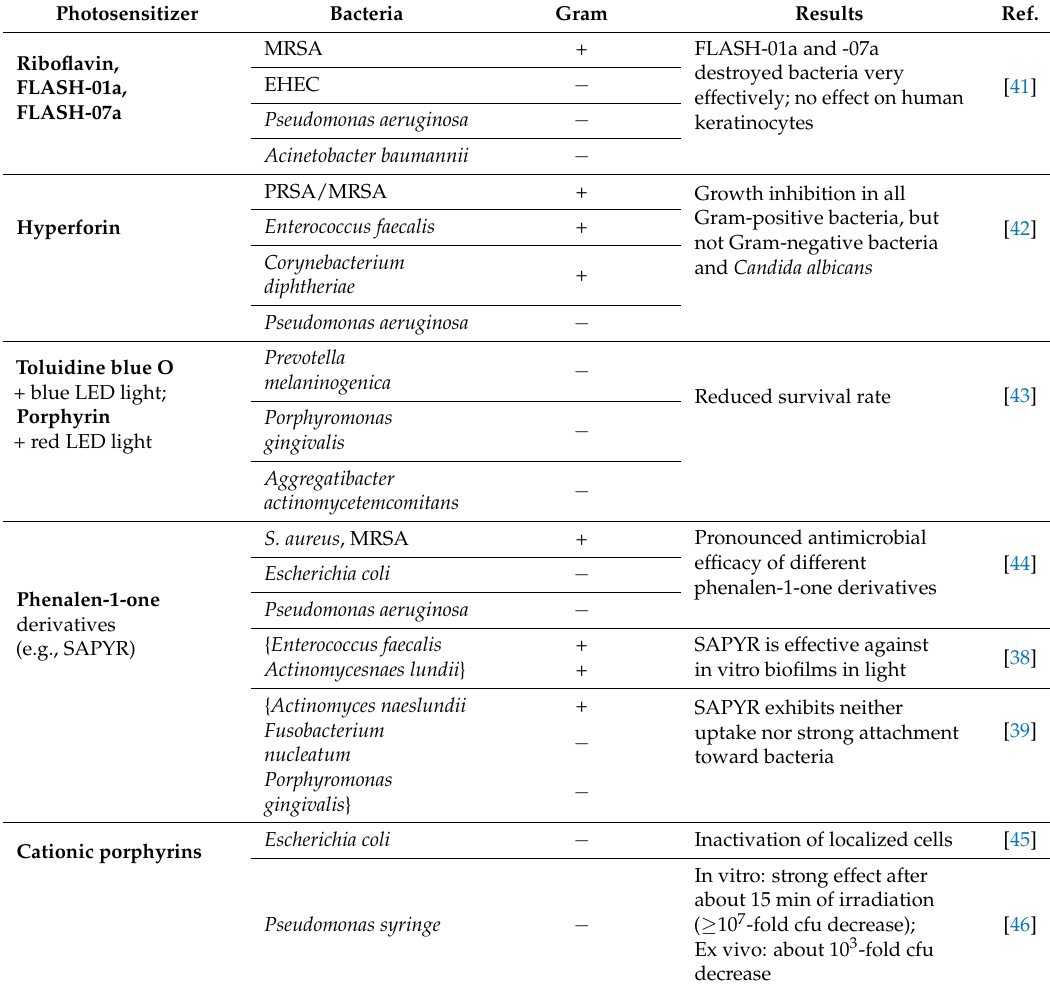
Table 1. Approaches for antimicrobial photodynamic therapies.